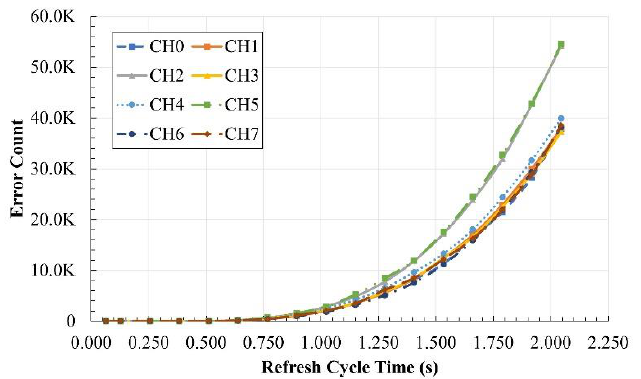
Figure 16. Retention error counts with varying RCT with T L fixed at 70 °C in Pseudo channel 0 of all the channels.